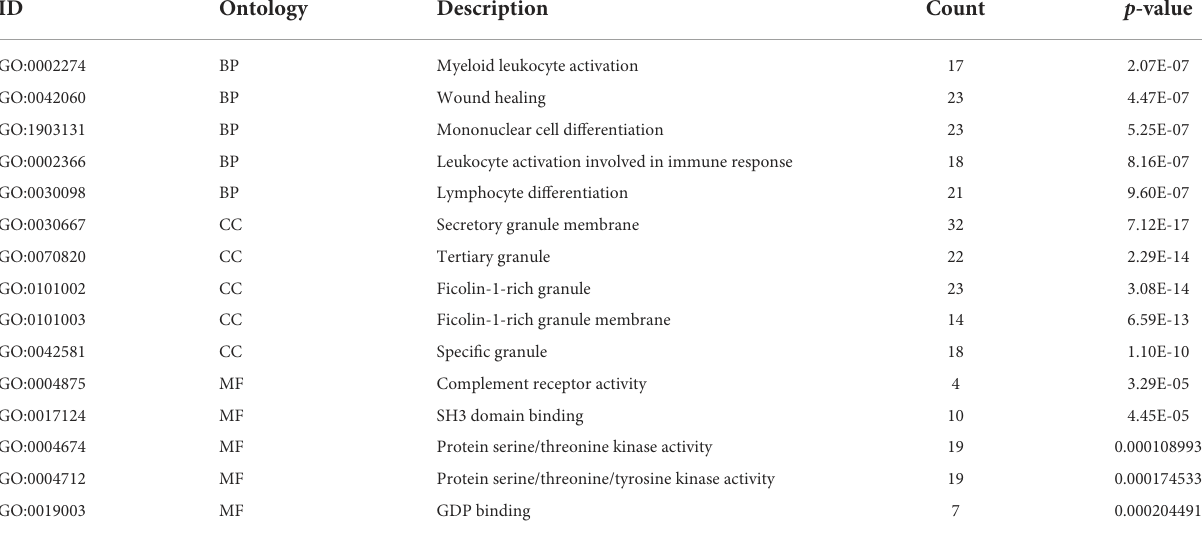
TABLE 2 GO analysis of upregulated common genes in